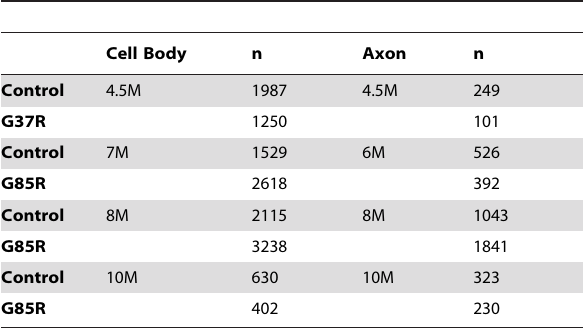
Table 1. Details on the number of individual mitochondria examined for all